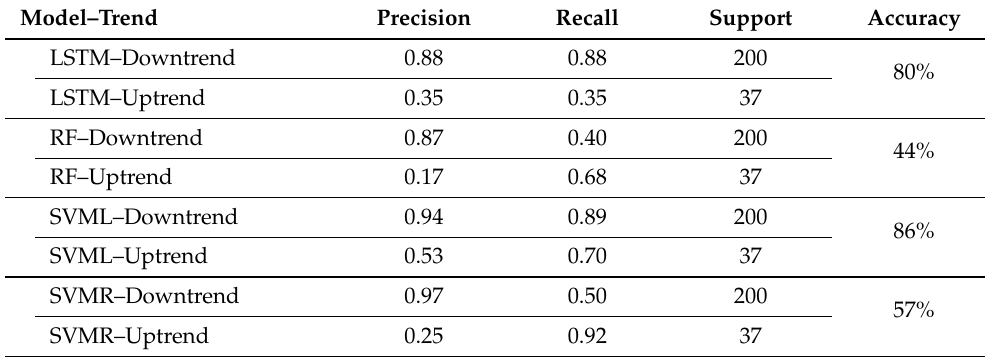
Table 5. Hit ratios of predictions to 252-days